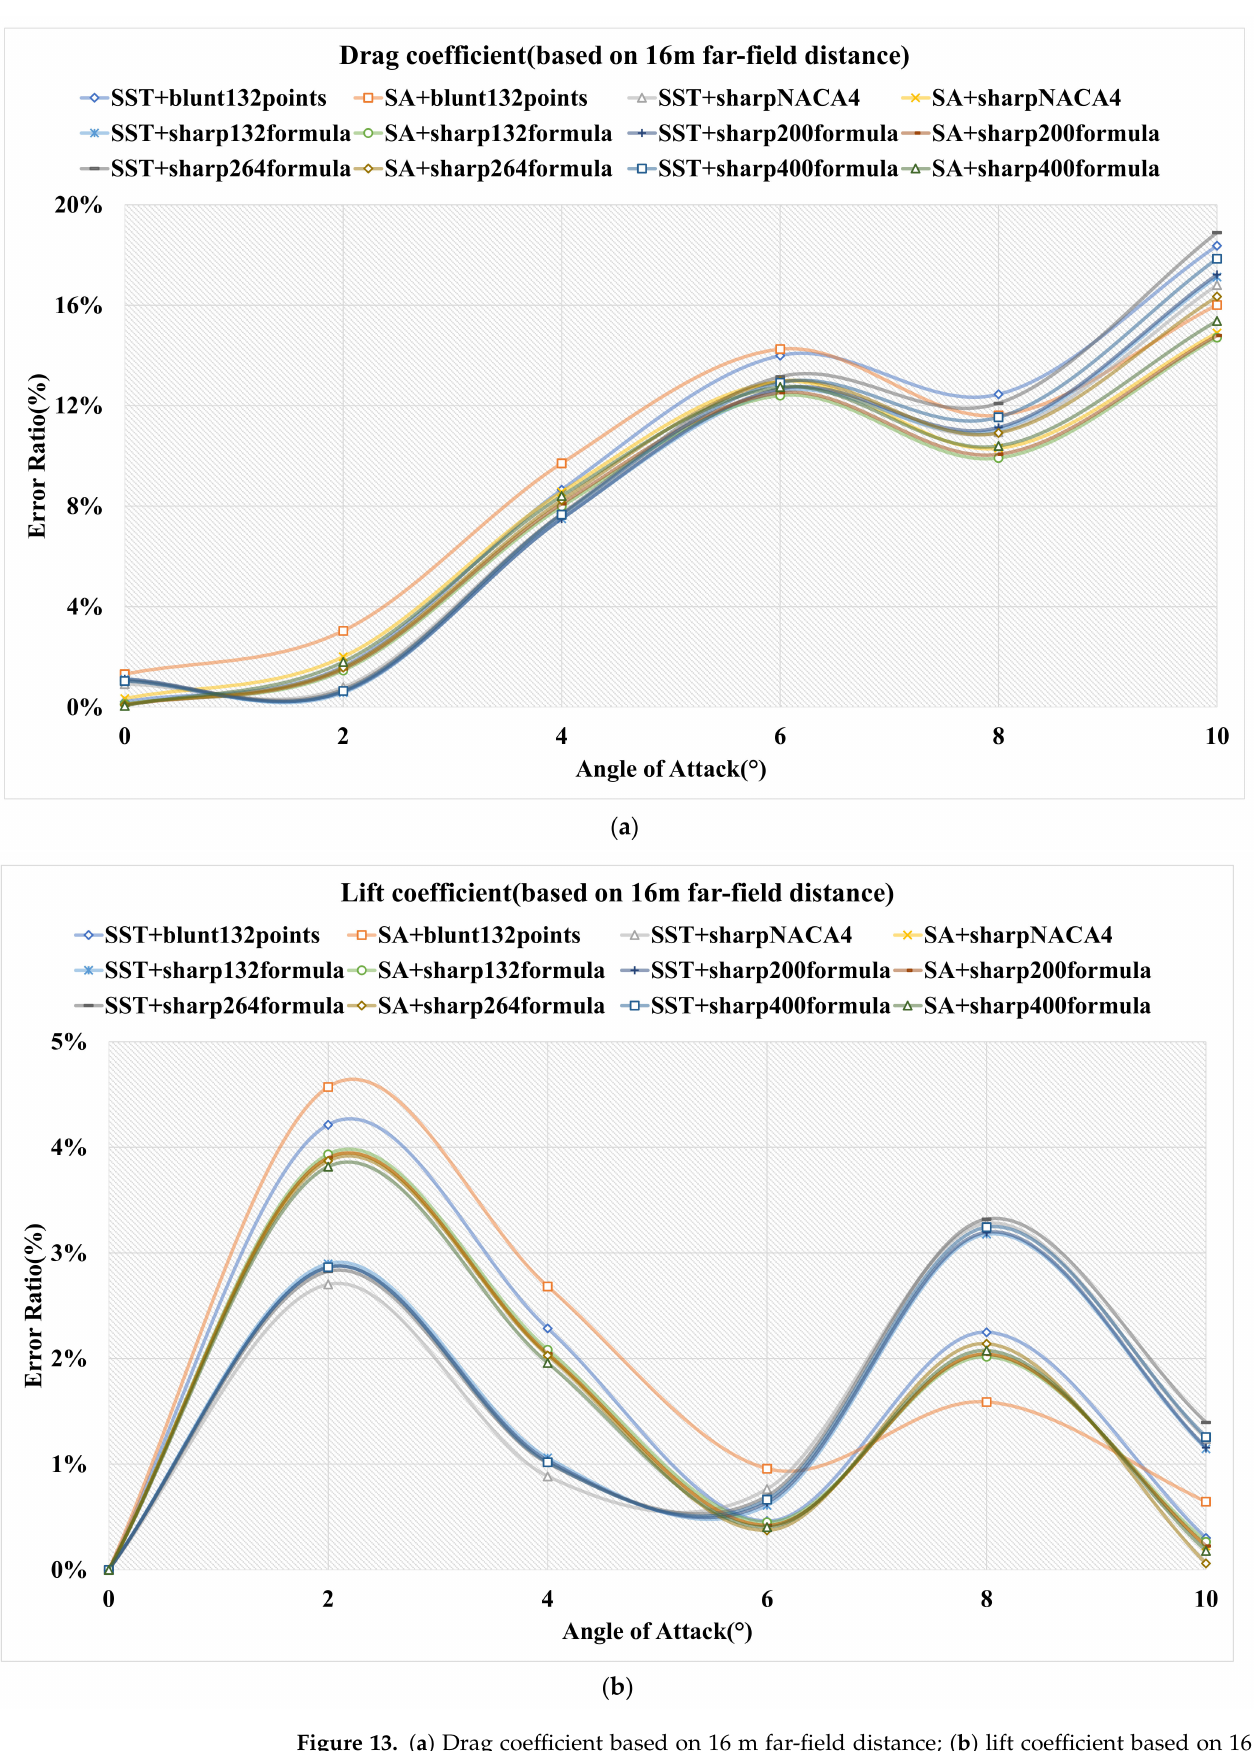
Figure 13. ( a ) Drag coefficient based on 16 m far-field distance; ( b ) lift coefficient based on 16 m far-field